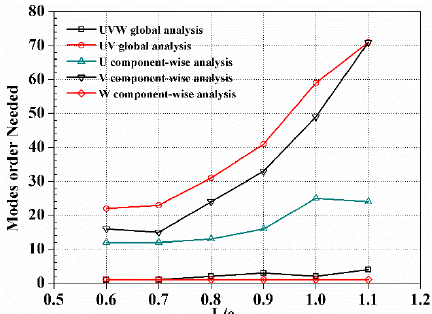
Figure 19. The modes required to represent 95% energy of the original flow field using five different POD processing